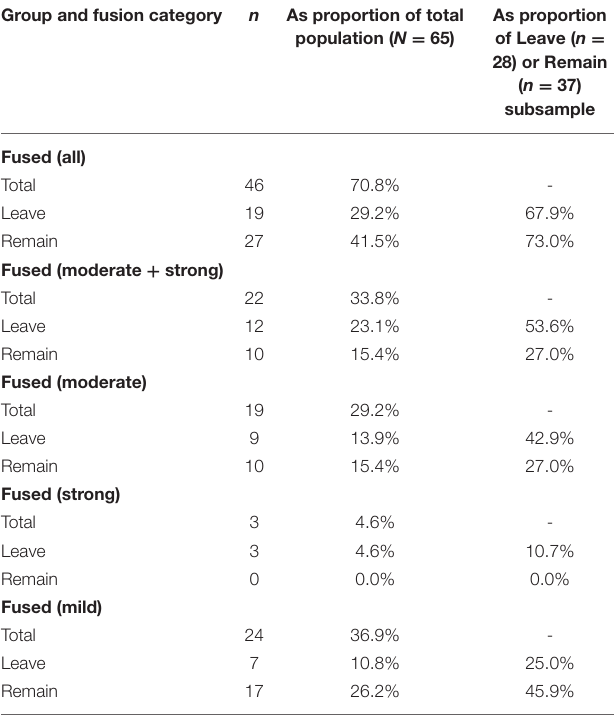
TABLE 1 | Identity fusion category according to Brexit referendum vote. Group and fusion